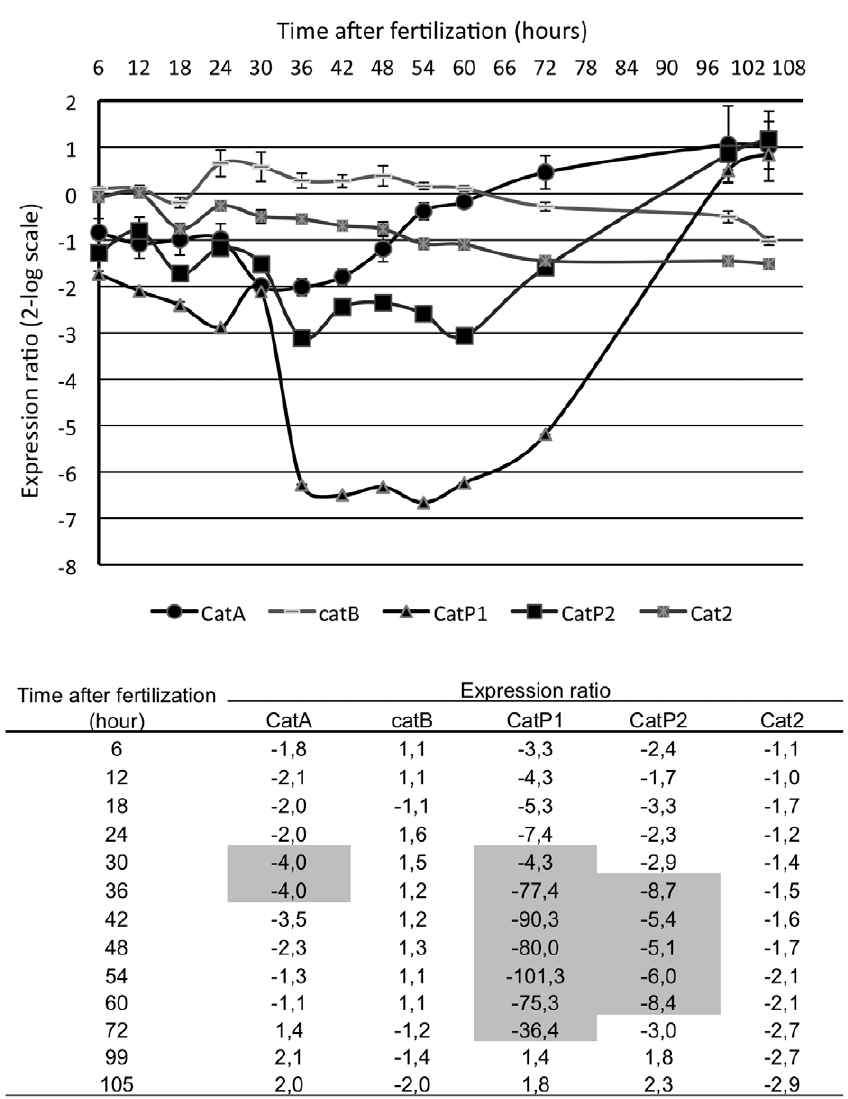
Figure 1. Expression of the five catalases genes at different stages of the sexual cycle. Gene expression was monitored by real time PCR using fertilization as time 0. Changes in gene expression are presented as x-fold change relative to expression at time 0 in 2-log scale. Standard deviations were obtained through three independent experiments and data were normalized by three reference genes (Materials and Methods). The Table below the graph gives the expression ratio of each gene at different times from 6 to 105 hours after fertilization. The significant ratios (p- value=0.001) are indicated by grey overlapping rectangles.